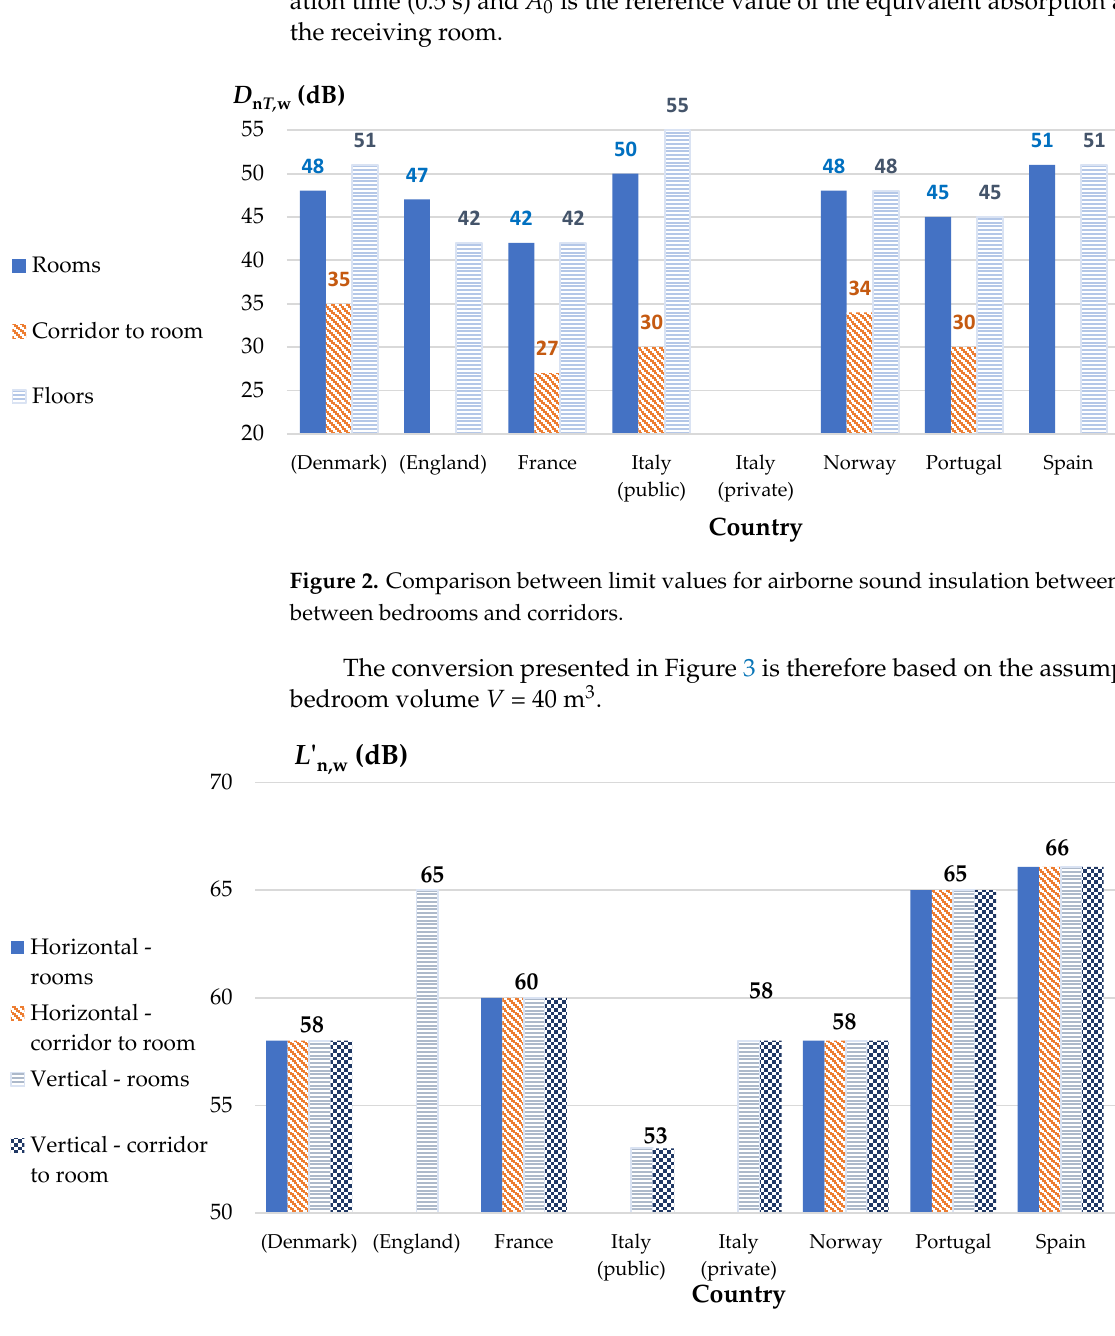
Figure 3. Comparison between limit values for impact sound insulation between bedrooms and between bedrooms and corridors.